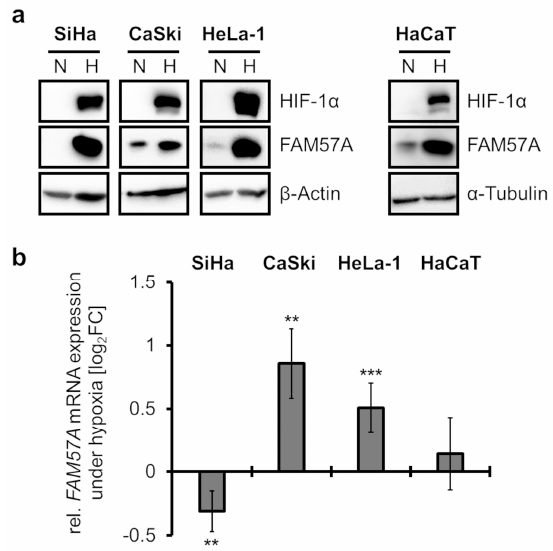
Figure 1. Comparative analyses of FAM57A protein and transcript levels in cells cultivated at normoxia or hypoxia. ( a ) HPV-positive cervical cancer cells (SiHa, CaSki, HeLa-1) and HaCaT keratinocytes were cultivated for 24 h at normoxia (N; 21% O 2 ) or hypoxia (H; 1% O 2 ) and analyzed by immunoblot for FAM57A protein levels. HIF-1 α , hypoxia marker; β -Actin and α -Tubulin, loading controls. ( b ) Corresponding qRT-PCR analyses of FAM57A transcript levels under the conditions outlined in subfigure ( a ). Shown are the log 2 -transformed fold changes (log 2 FC) of mean expression in cells cultivated at hypoxia compared to normoxia, with standard deviations from at least 3 independent experiments. Statistically significant differences in cells cultivated at hypoxia compared to normoxia (log 2 FC = 0) are determined by one-way ANOVA. **: p < 0.01, ***: p < 0.001.